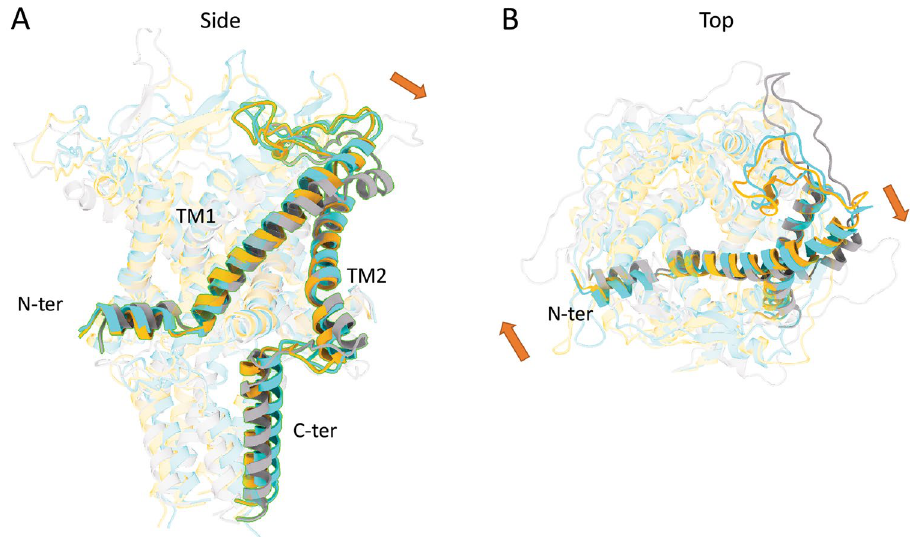
Figure 3. Structural rearrangement of MscL helices due to 5-FU and TFE insertion using MD simulations. Red arrows show the parts of the channel that are moving due to the presence of the drugs. Cyan WT (not treated), Grey is 5FU and Orange is TFE.